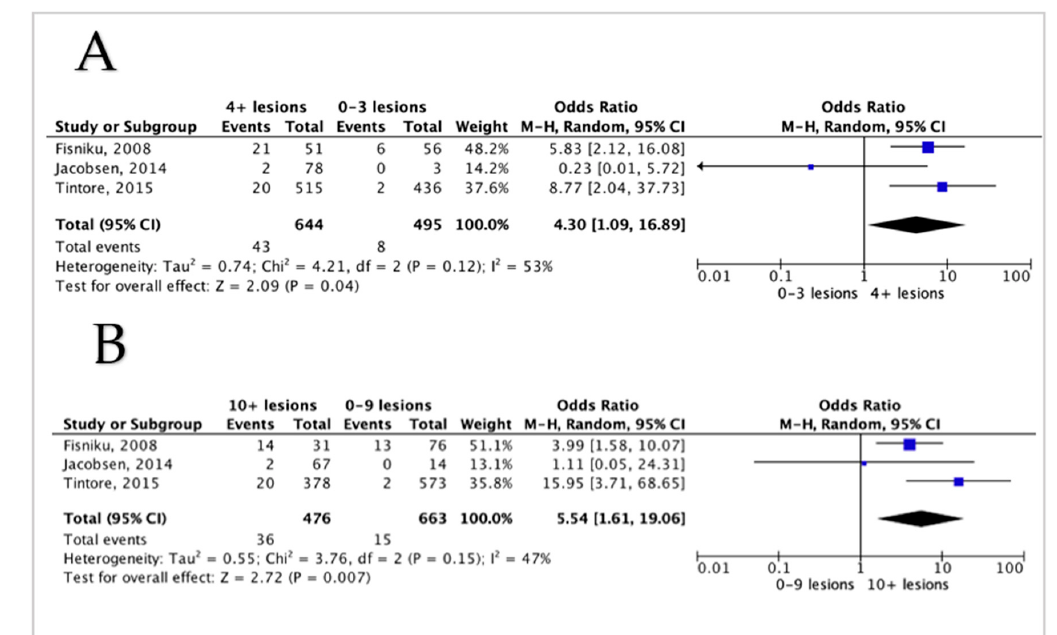
Figure 3. Forest plot demonstrating the odds of EDSS 6 with comparisons between different lesion counts ( A , B ); ( A ) a comparison between 0–3 lesions versus 4 or more lesions, ( B ) a comparison between lesions of 0–9 lesions versus 10 or more lesions. CI = confidence interval, I 2 = heterogeneity index, df = degree of